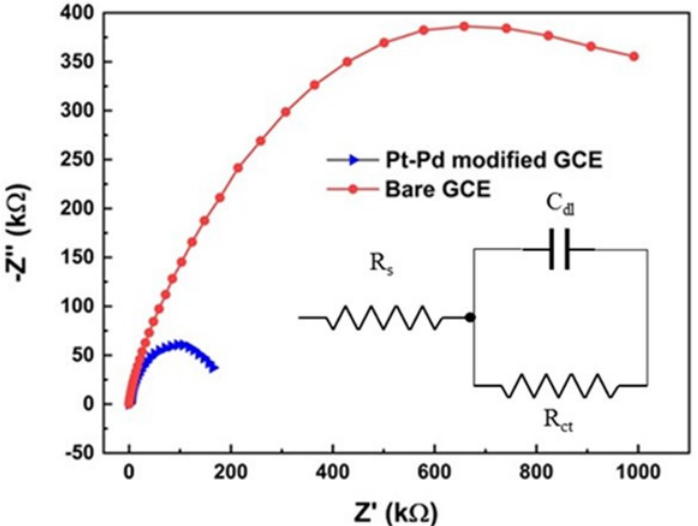
Figure 3. EIS Nyquist plots of the bare and the modified electrodes in BR buffer solution (pH 2). Rs: Solution resistance, Cdl: The capacitance of the electrical double layer at the electrode–solution interface, and Rct: The charge transfer resistance .